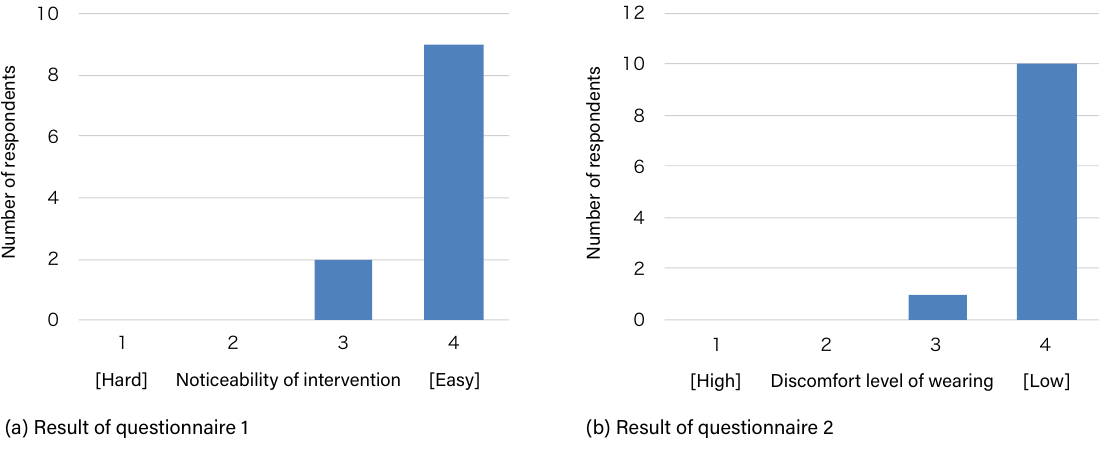
Figure 17. Results of questionnaires on intervention